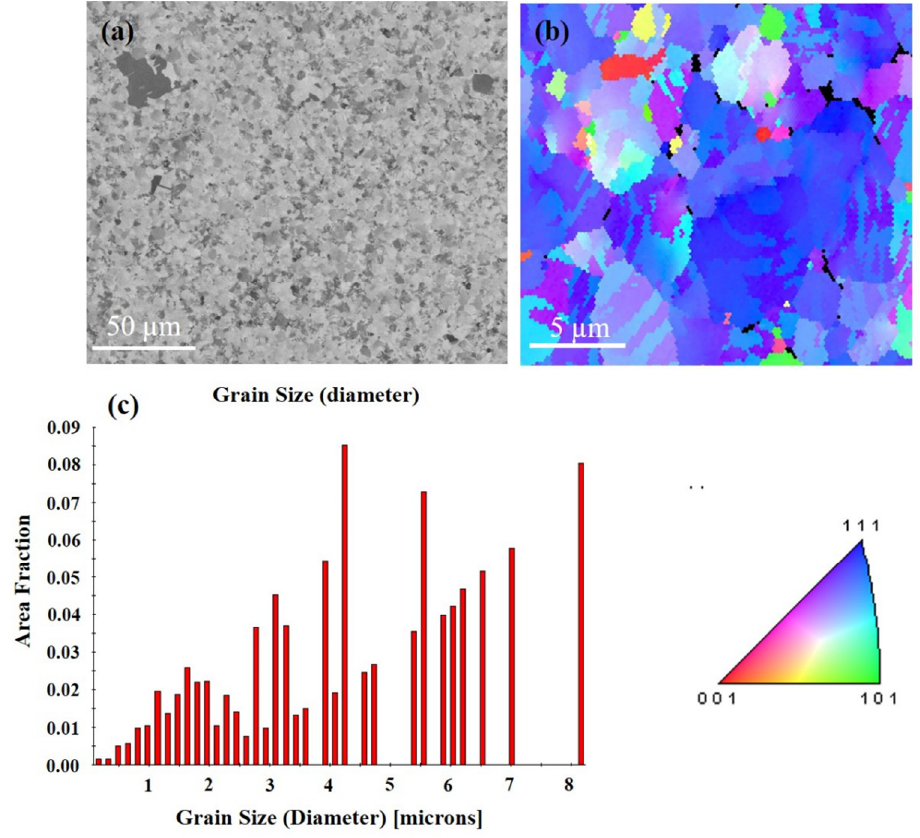
Figure 4. Grain morphologies for the Cu film at 200 °C for an hour. ( a ) FIB top-view image. ( b ) EBSD orientation image. ( c ) Grain size distribution of the grains in pole Figure 4b.